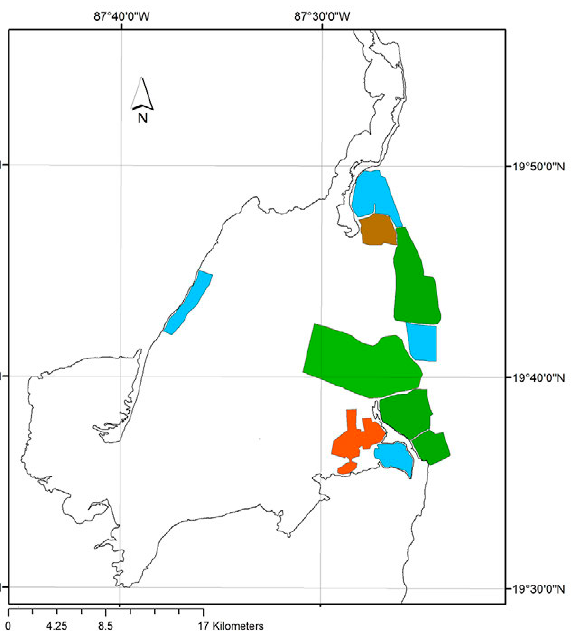
Fig. 4. – Four homogenous groups of fishing areas (orange, blue, green and brown) for the mean number of artificial shelters har- vested per trip identified using a Tukey HSD test.